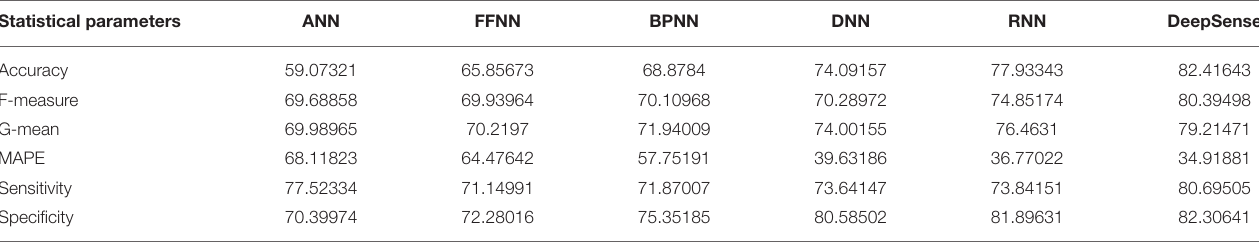
TABLE 3 | Results of statistical parameters for CORD-19 with 70% training data on 1,000 images.